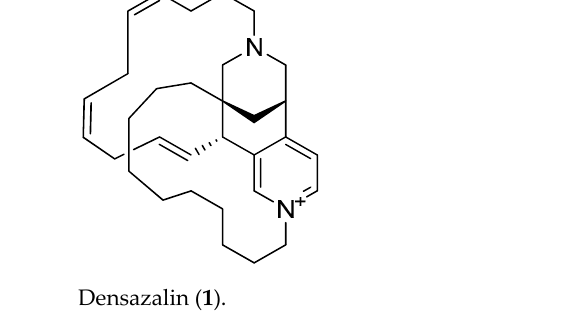
Table 1. 1 H (500 MHz) and 13 C NMR (125 MHz) data for compound 1 in CD 3 OD ( δ in ppm, J val- ues in